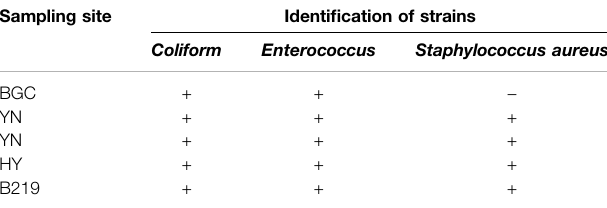
TABLE 2 | Results of puri fi cation of